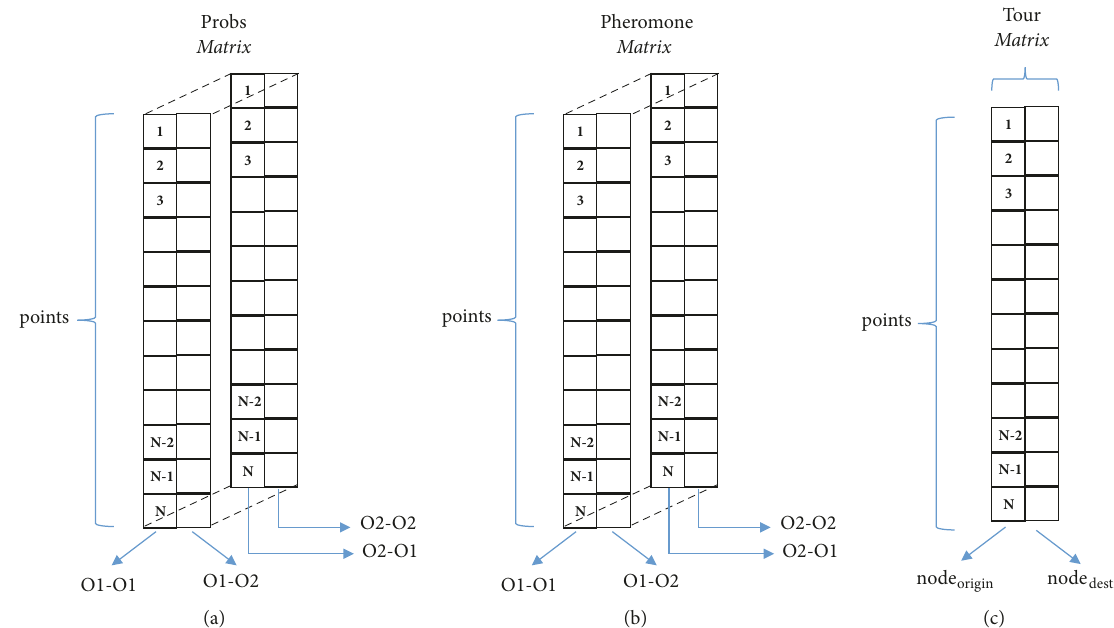
Figure 18: (a) Representation of probability matrix. Each box stores the probability of traversing the arch (𝐶 𝑖 ,𝐶 𝑗 ) . (b) Representation of the pheromone matrix, each box represents the amount of pheromone deposited by an ant when traversing the arch (𝐶 𝑖 ,𝐶 𝑗 ) . (c) Representation of the route matrix, the column on the left represents the departure node at position 𝑖 and the right column represents the destination node at position 𝑗